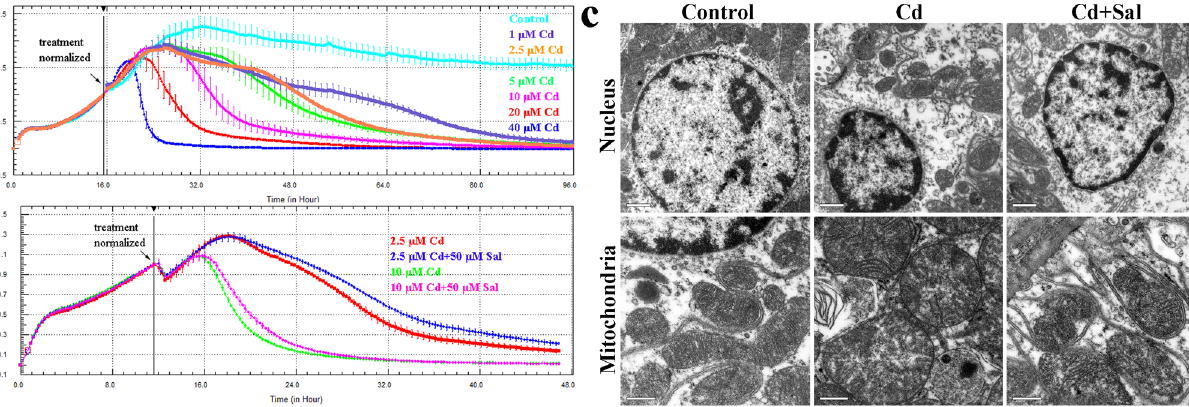
Fig 2. Cd triggers cytotoxicity in BRL 3A cells and rat liver tissue. a , b : The effect of Cd treatment and Sal on the cell index in BRL 3A cells. Data were normalized at the time of treatment. Curves were plotted as an average of quadruplicate treatments. Error bars show the standard deviation. c : Transmission electron microscopy reveals the ultrastructure changes of nuclei and mitochondria. Bar = 0.5 μ m.